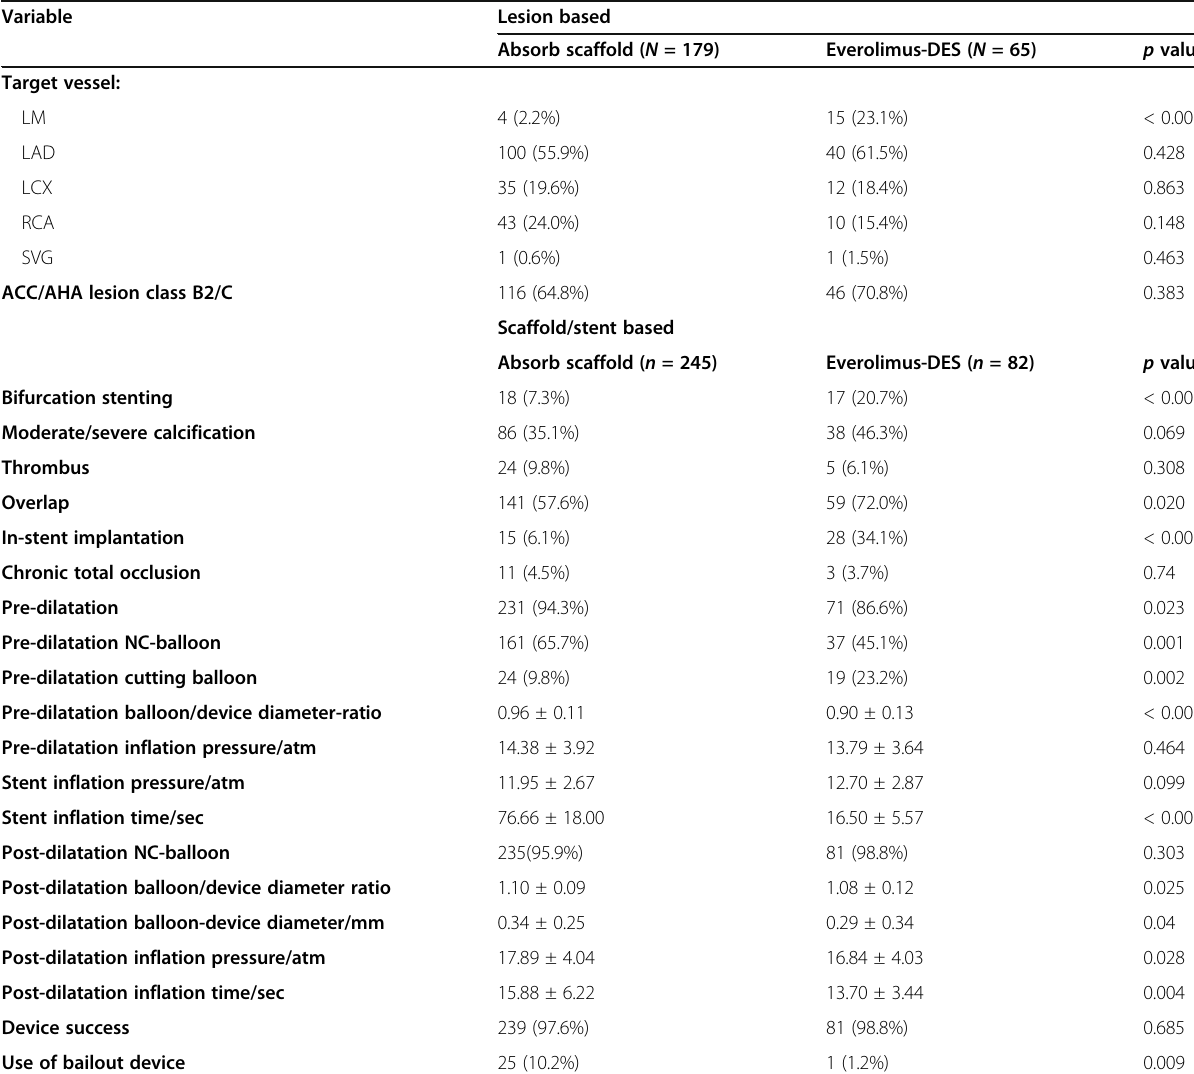
Table 2 Lesions and procedural characteristics